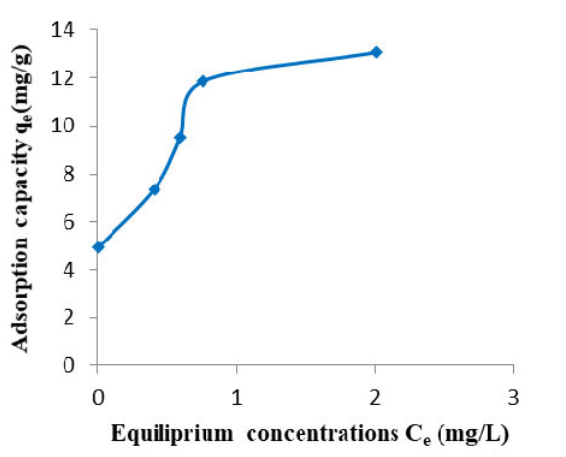
Fig. 10. Adsorption capacity of Cd 2+ onto SEZ Fig. 11 . Effect of initial concentration on removal